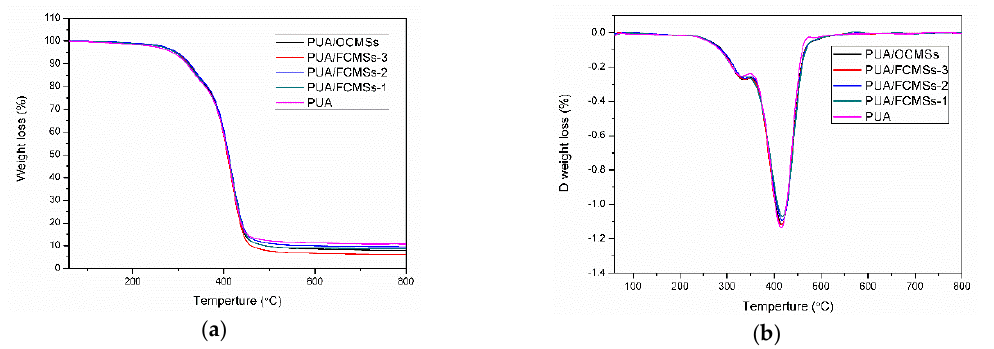
Figure 10. ( a ) The thermogravimetric analysis (TGA) spectra of UV cured films; ( b ) The Differential thermal gravity (DTG) spectra of UV-cured films.